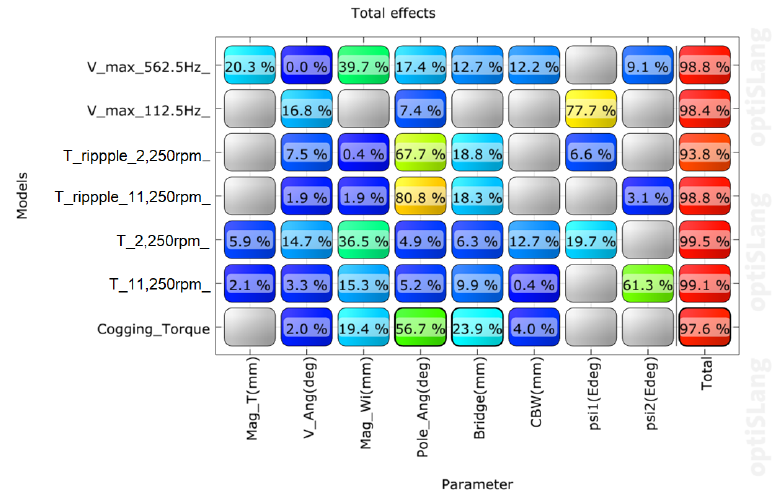
Figure 3. Sensitivity analysis results.